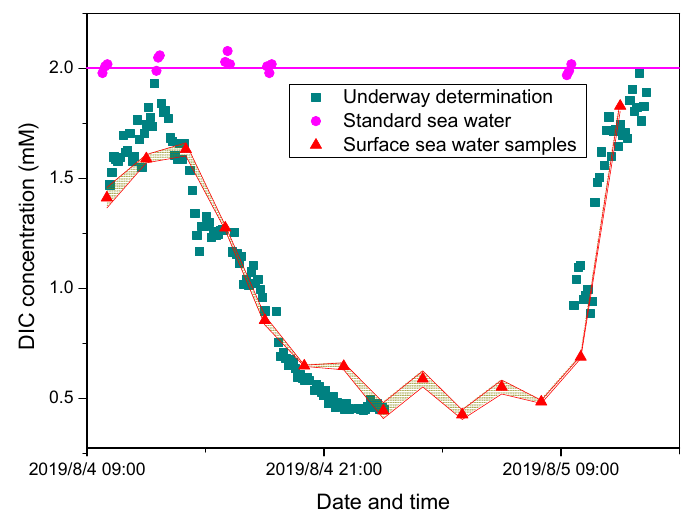
Figure 7. Relationship between surface sea water samples DIC detection and underway DIC observation results .